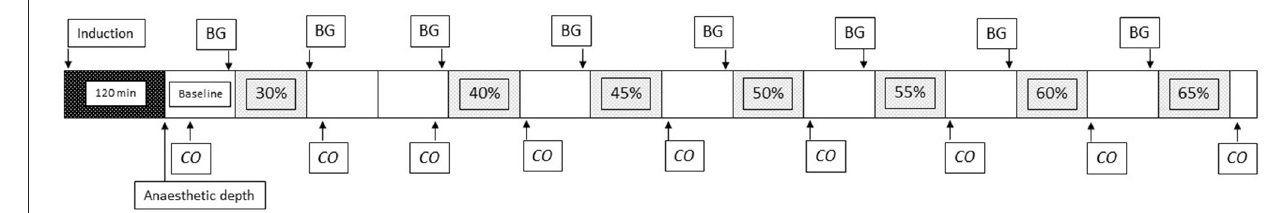
FIGURE 1 | Timeline of the experiment. Figure showing timeline of the experiment. Evaluation of anesthetic depth, percentage of total blood volume removed, measurement of cardiac output ( CO ), and sampling time point for blood gases (BG) are shown. The first box (black) represents the 120min from induction of anesthesia until start of the experiment. Each additional box represents